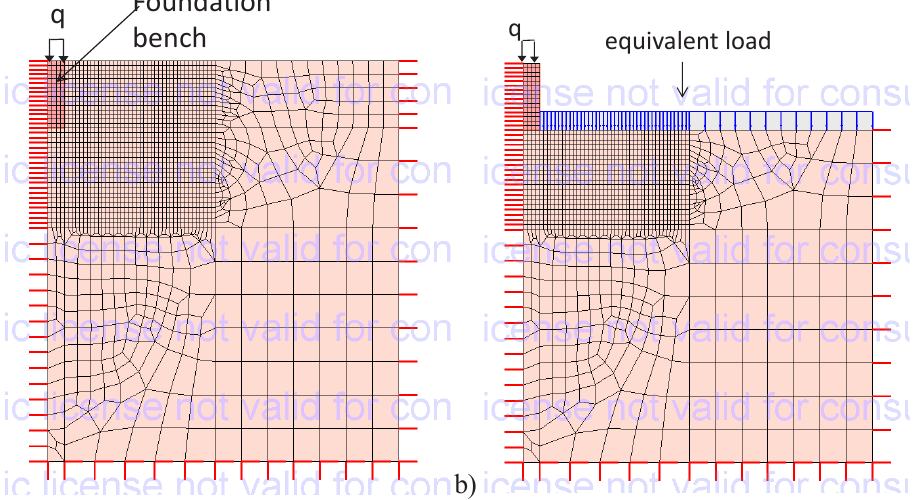
Figure 5: 2D numerical model of the simple single bench with boundary conditions—with soil above foundation level modelled as: a) a Coulomb- Mohr continuum, b) an equivalent load.